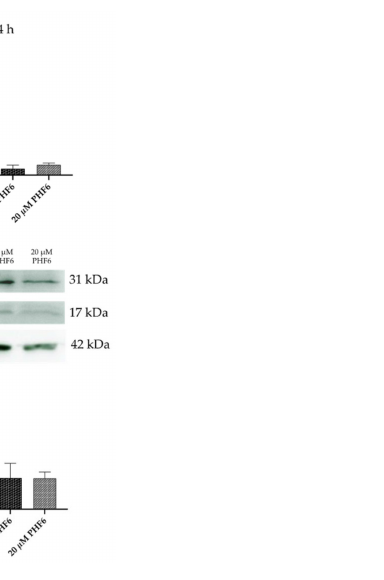
Figure 6. Aggregated PHF6 induced upregulation of IL1 β mRNA and protein in HMC3 cells after 6